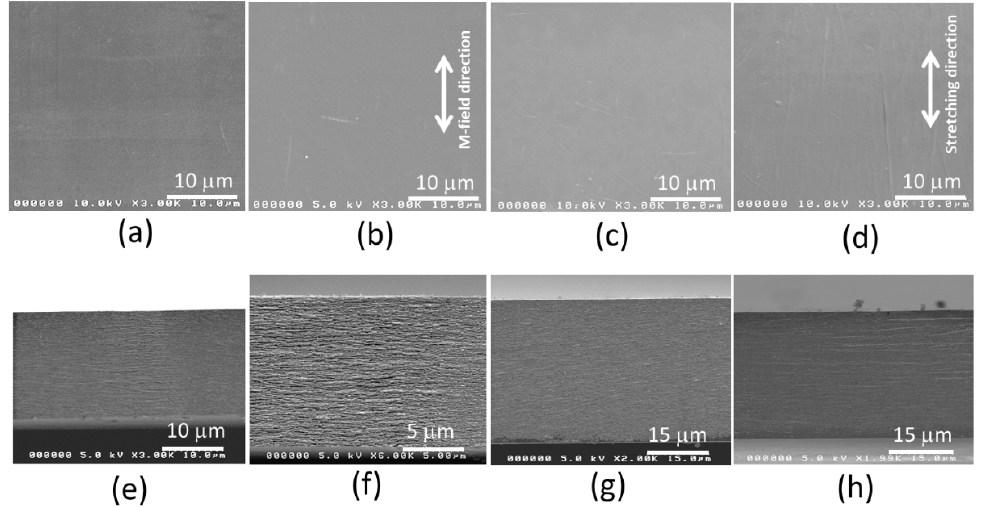
Figure 6. ( a,e ) Surface and cross-sectional SEM images of the pure CNF film ( a , d ); the magnetic-field applied CNF film ( b , f ); the pure CNF/PVA film ( c , g ); and the mechanically stretched CNF/PVA film ( d , h ).